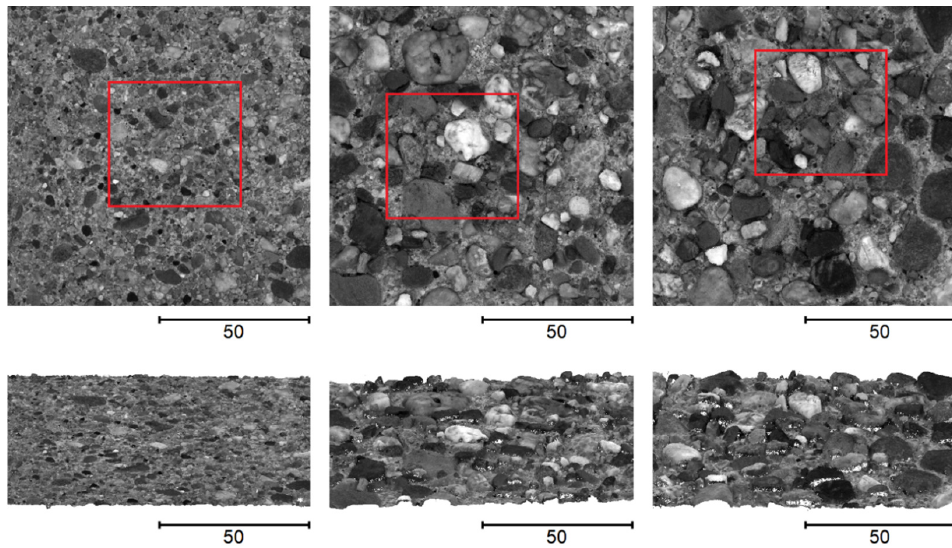
Figure 8. Reconstructed point clouds of the three specimens using our camera-based system, in top and oblique view—to the left specimen 1, in the center specimen 2 and to the right specimen 3.